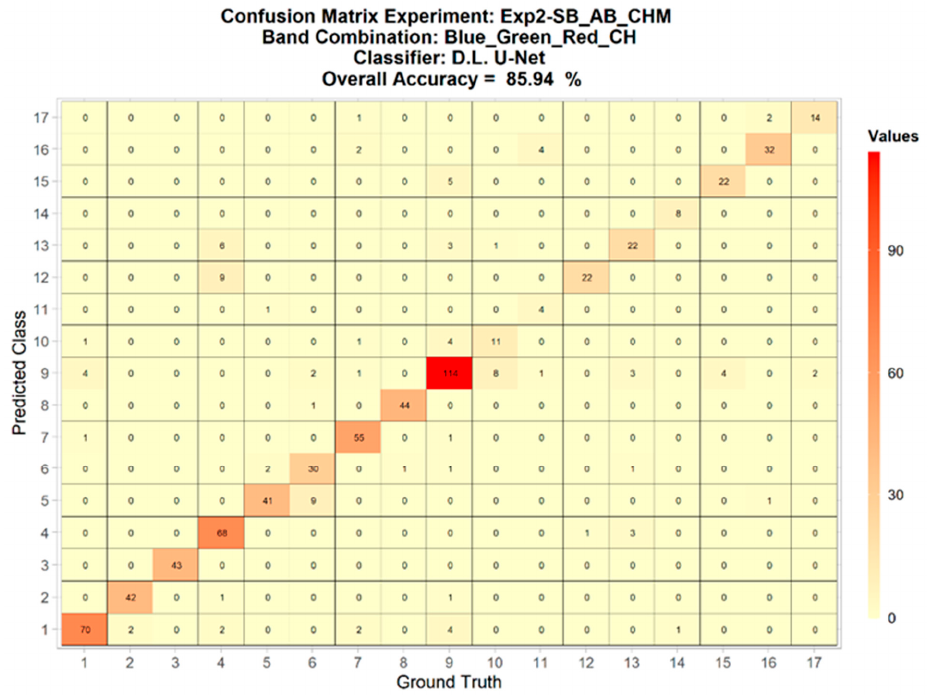
Figure A16. Confusion matrix for the best results obtained in Exp2-SB_AB_CHM, using the Deep Learning classifier with the DeepLabV3 architecture (the Green_Red_RE_CH band combination).